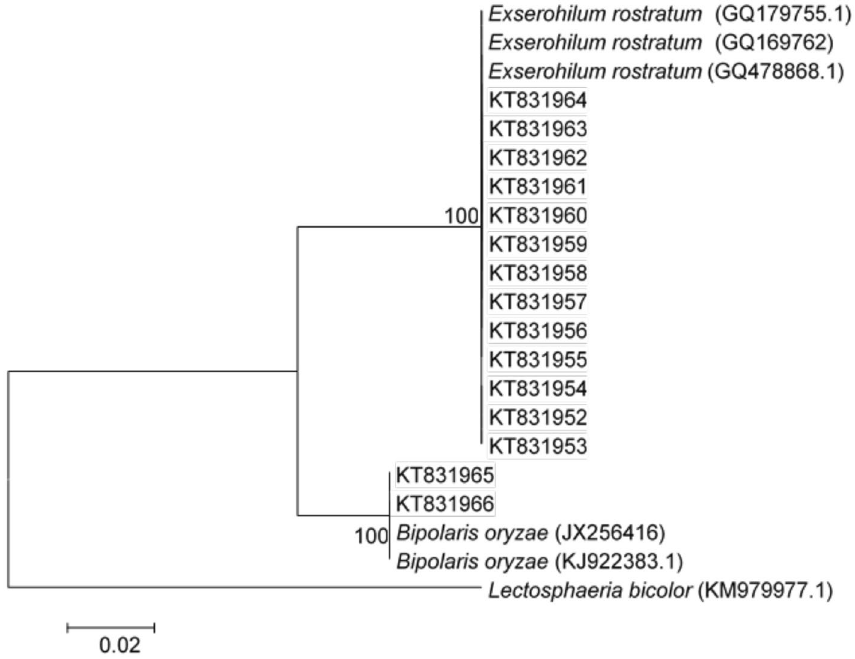
Figure 3. Phylogenetic analysis of rDNA-ITS region of fungal isolates obtained from brown spot diseased rice plants in Peninsular Malaysia. The evolutionary analysis of both Exserohilum rostratum and Bipolaris oryzae is inferred based on rDNA-ITS sequences using Neighbour-Joining method with 500 replications. Reference sequences including E. rostratum (GQ179755.1, GQ169762, GQ478868.1), and B. oryzae (JX256416 and